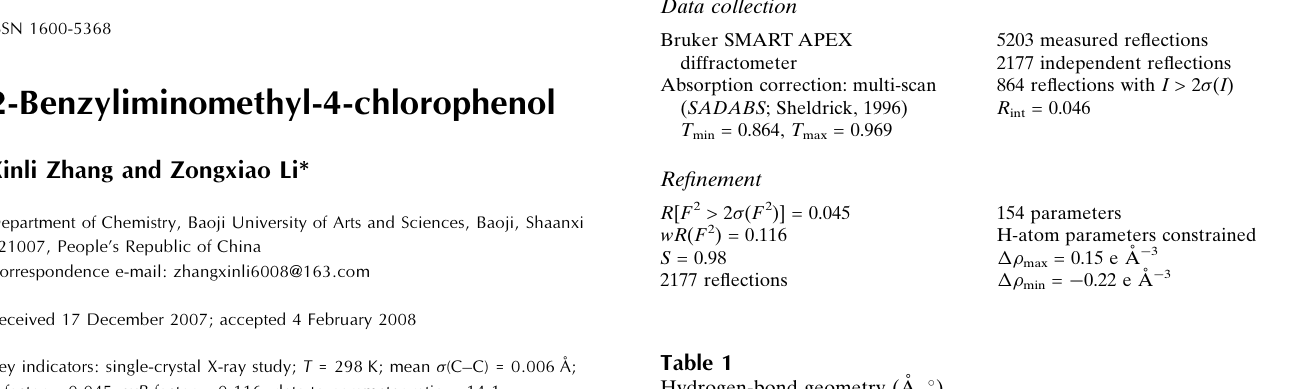
Hydrogen-bond geometry (A˚ , (cid:2)